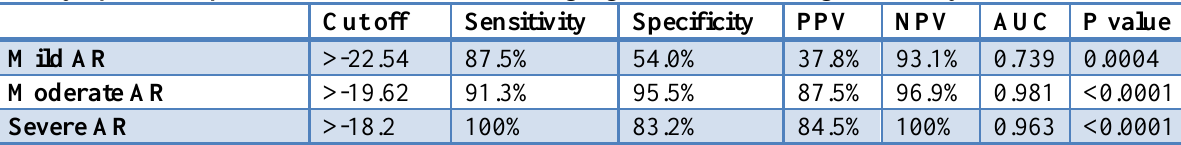
Table 6: Predictive characteristics of GLS for the detection of left ventricular systolic dysfunction in asymptomatic patients with chronic aortic regurgitation (According to severity)